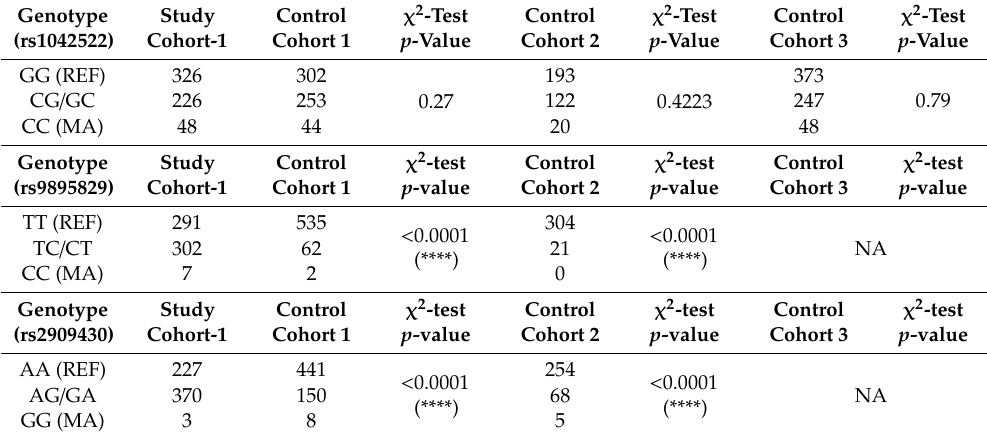
Table 1. Comparison of rs1042522, rs9895829 and rs2909430 frequencies in the study cohort-1 (cancer) and control